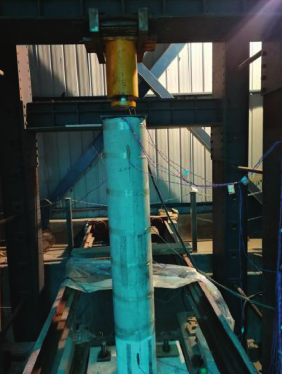
Figure 6: Impacted specimen and constraints.